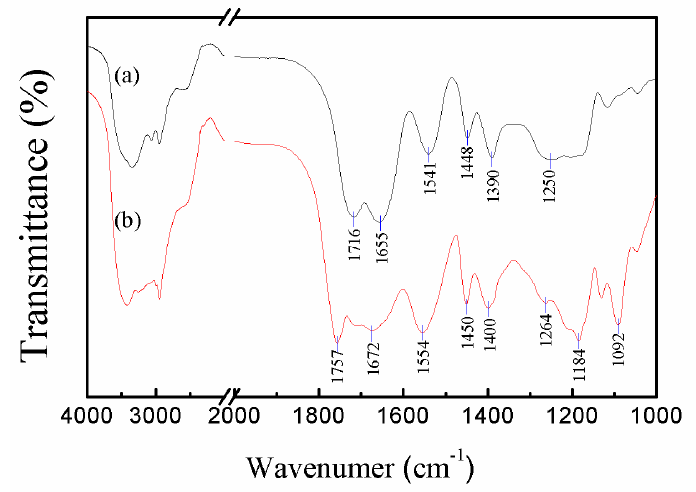
Figure 1. FTIR spectra of the ( a ) P(AA- co -NVF) and ( b ) P(AA- co -VAm) microgels.